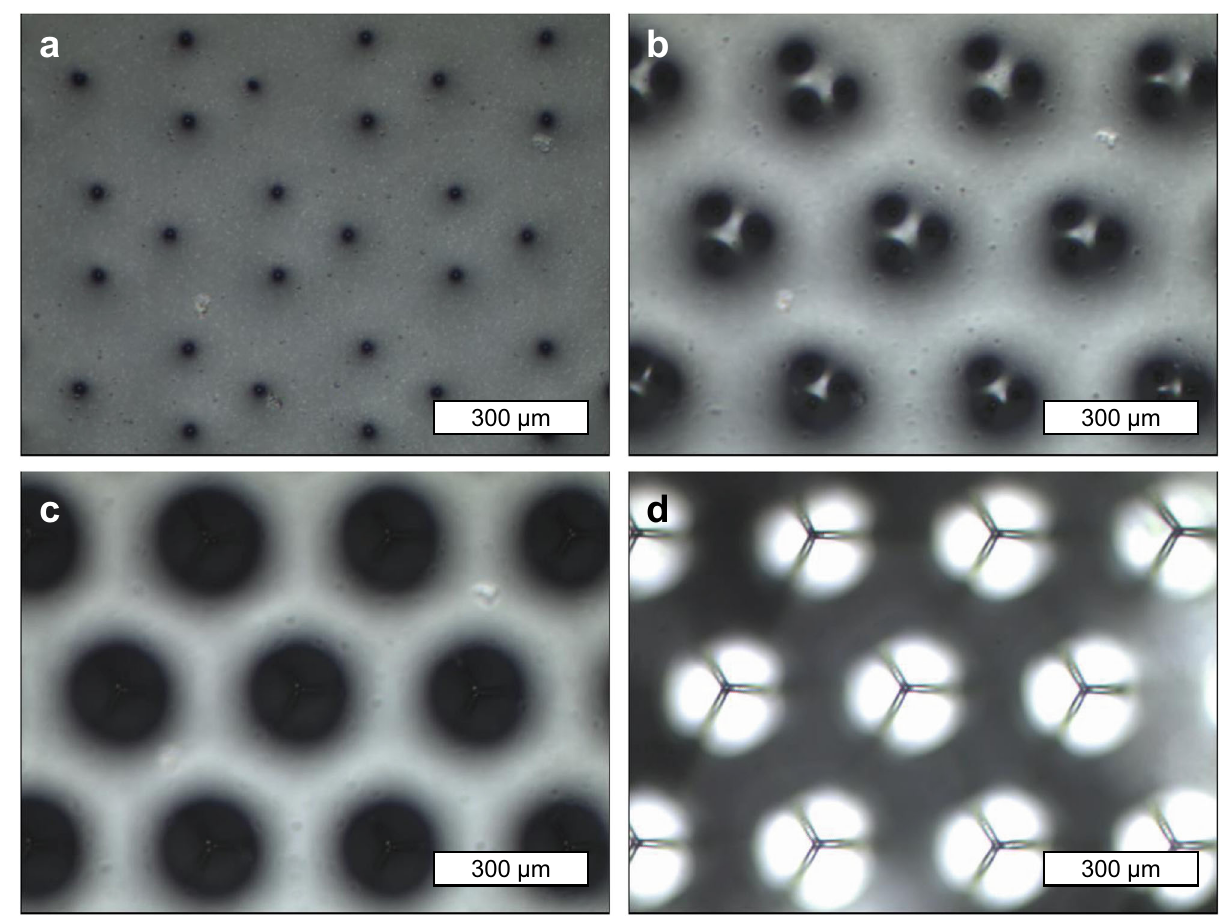
Fig. 3 | Microscopic images of micropillars clustering as PVA solution dry out. a Micropillars at their initial position with pillar tips partially immersed by PVA solution. b Micropillars being bent due to the capillary force of PVA solution.